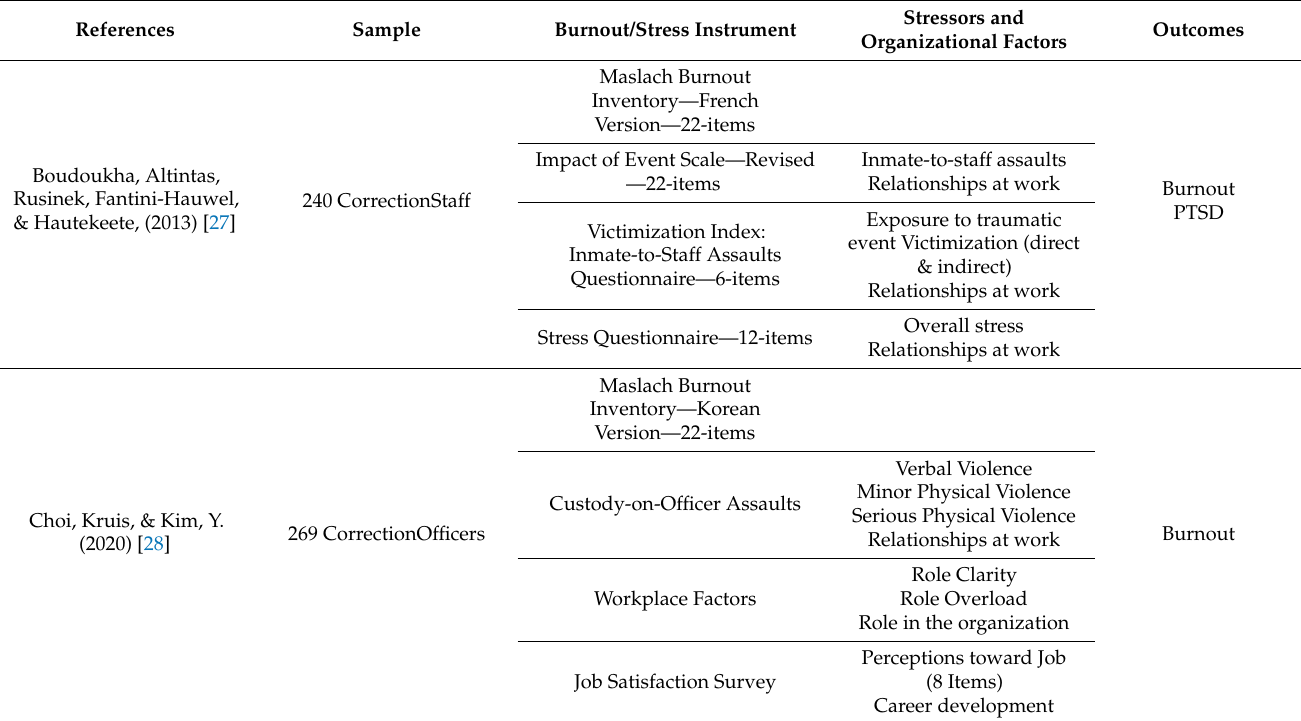
Table 3. Stage 1 Characteristics of included